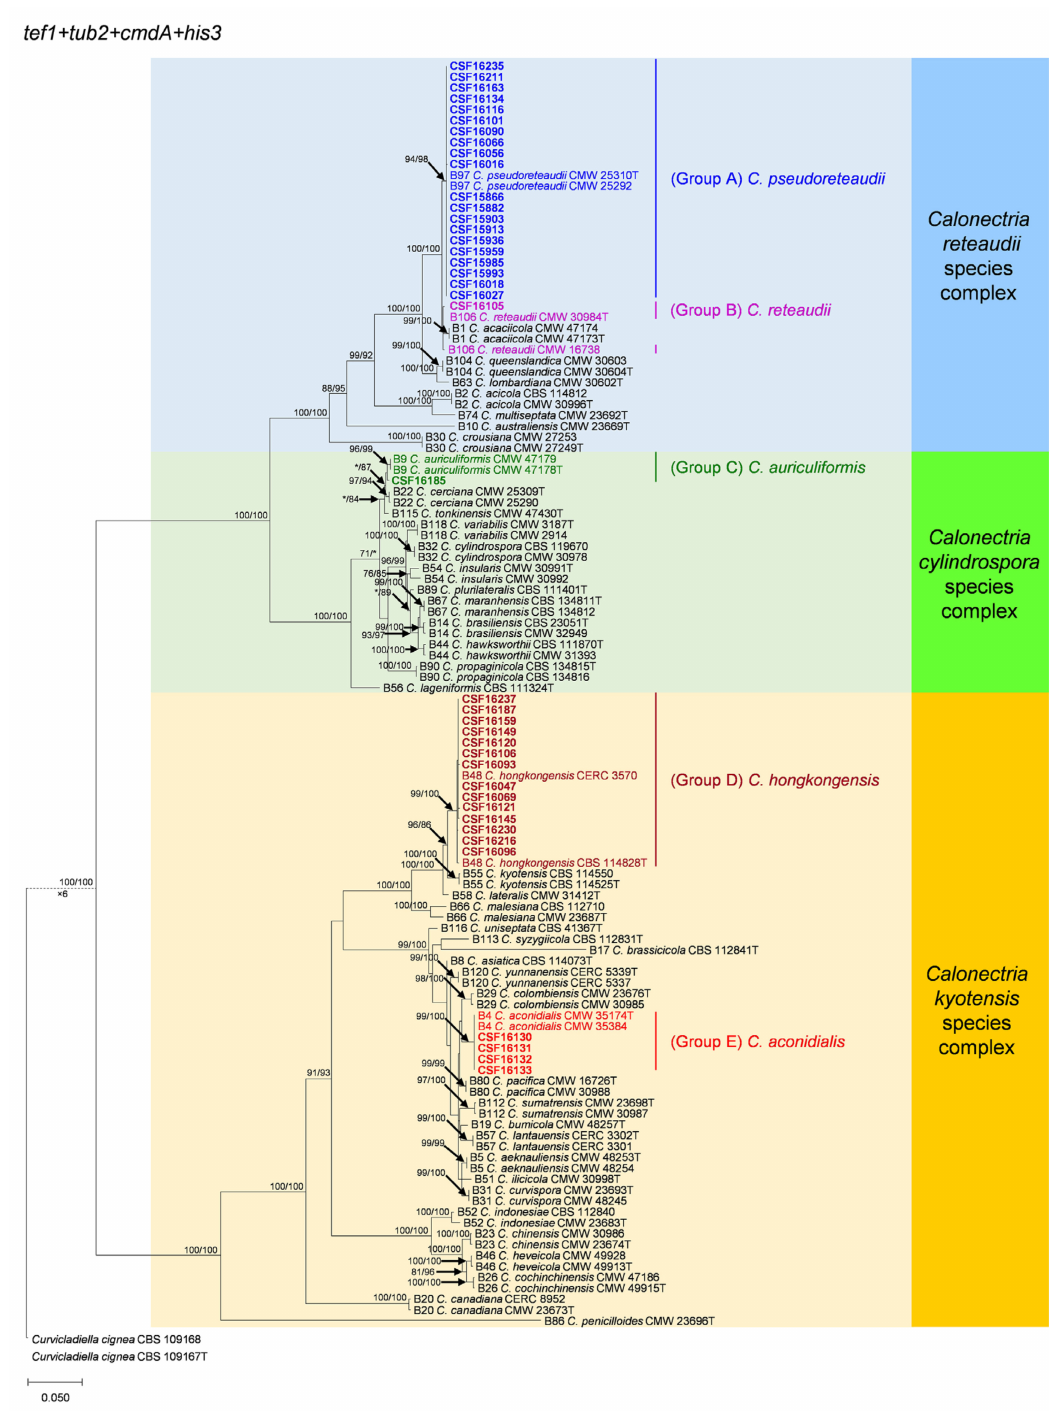
Figure 2. Phylogenetic tree of Calonectria species based on maximum likelihood (ML) analyses of the dataset of combined tef1 , tub2 , cmdA and his3 gene sequences in this study. Bootstrap support values ≥ 70% are presented above the branches as follows: ML/MP. Bootstrap values <70% and absent are marked with “*”. Isolates highlighted in five different colors and bold were obtained in this study. Ex-type isolates are marked with “T”. The “B” species codes are consistent with the recently published results in Liu and co-authors [28]. The Curvicladiella cignea (CBS 109167 and CBS 109168) was used as outgroup